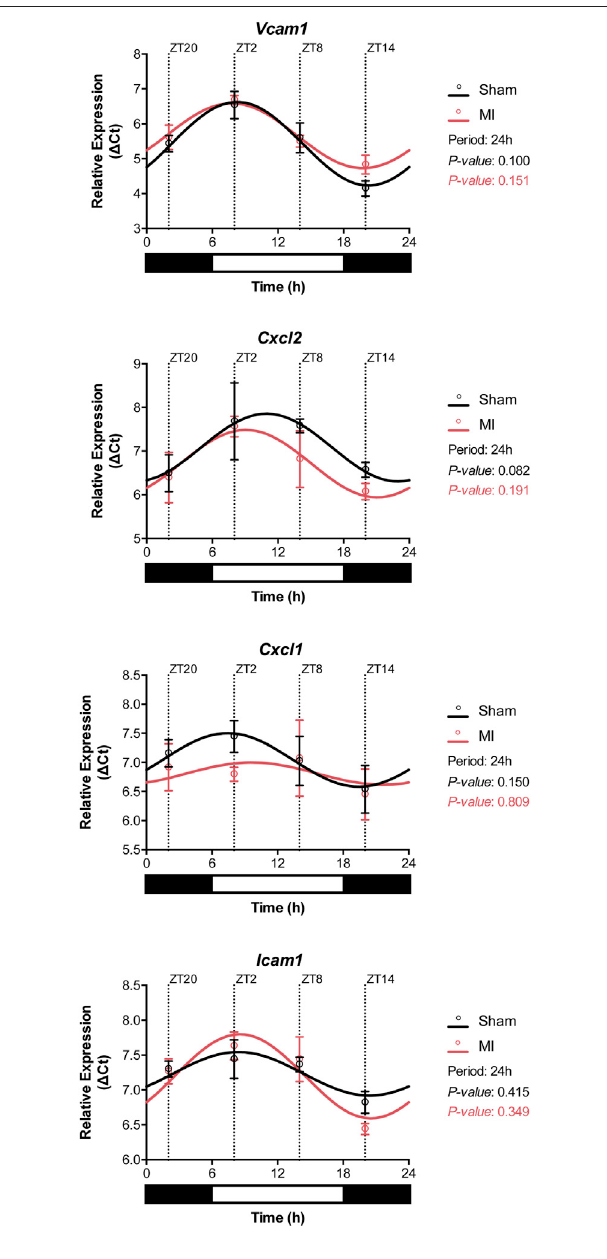
FIGURE 5 | Gene expression of adhesion molecules in the heart. The expression of Vcam1 , Cxcl2, Cxcl1, and Icam1 followed circadian-like oscillations with higher levels present during the active phase (ZT14-ZT20). ( n = 3 per group/timepoint for all analysis, p -values determined by Cosinor analysis using the online platform: Cosinor. Online (https://cosinor. online/app/cosinor.php)).